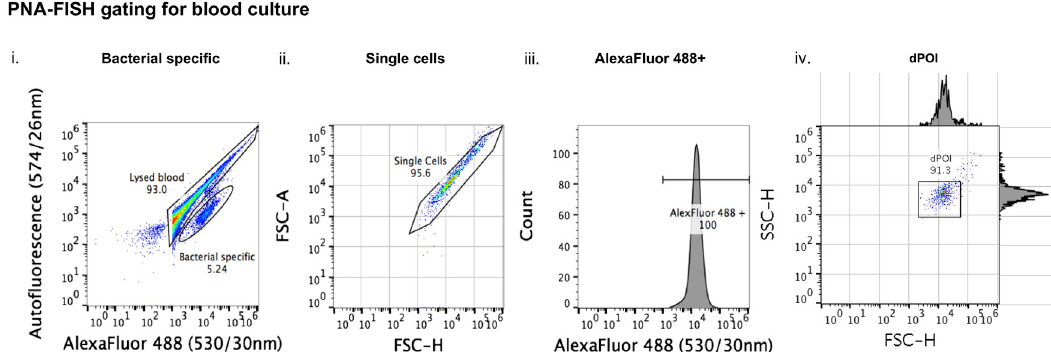
Fig 4. Gating of PNA-FISH hybridized BC samples. Bacteria-specific events were separated from the background noise of lysed blood based on a difference between the PNA probe-specific signal and autofluorescence produced by blood (i). This was followed by identification of single cells on the FSC-H/FSC-A scatter plot within the bacterial population (ii). Probe specific signal was gated as AlexaFluor 488 + on the histogram (iii), and all events within this gate were backgated and shown on the FSC-H/SSC-H plot as dPOI